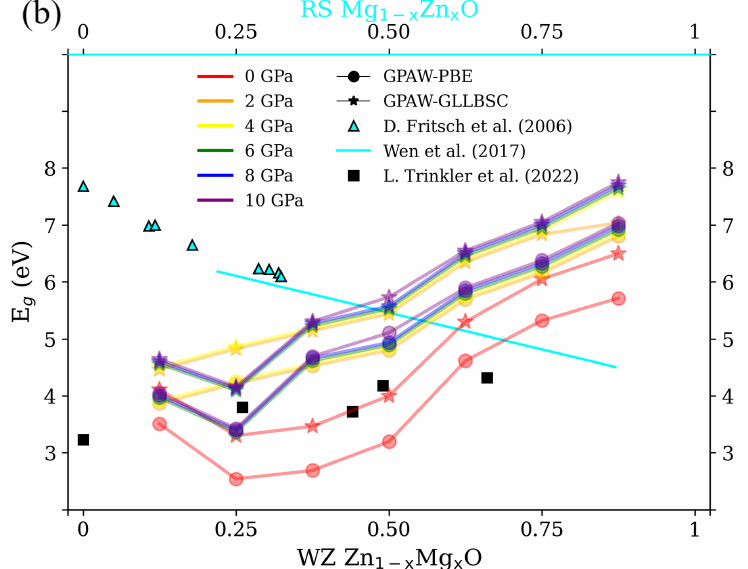
Figure 3. ( a ) Optimized structures and band gap ( E g ) of wurtzite (WZ) Zn 1 − x Mg x for the WZ ZMO1 model in Figure 1 with x = 0.125, 0.25, 0.375, 0.5, 0.625, 0.75 and 0.875 as well as the pressures from 0 GPa to 10 GPa in 2 GPa increments. In Subfigure ( a ), the colors orange, grey and red correspond to magnesium, zinc and oxygen, respectively. The experimental data of the line and triangles for rocksalt (RS) Mg 1 − x Zn x O are colored cyan; the black squares are the experimental results of WZ Zn 1 − x Mg x O. The other symbols, colors and legends of Subfigure ( b ) are identical to the descriptions in Figure 2b. The top label of cyan color corresponds to the expression of rocksalt (RS) Mg 1 − x Zn x O for experimental concentration. The E g detailed in Appendix A of Table A2 corresponds to the values in Subfigure ( b )